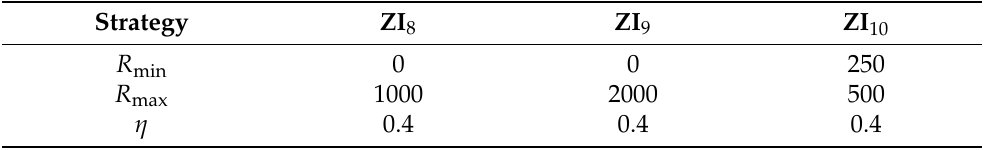
Table 2. Additional background trading strategies included in EGTA for cloaking